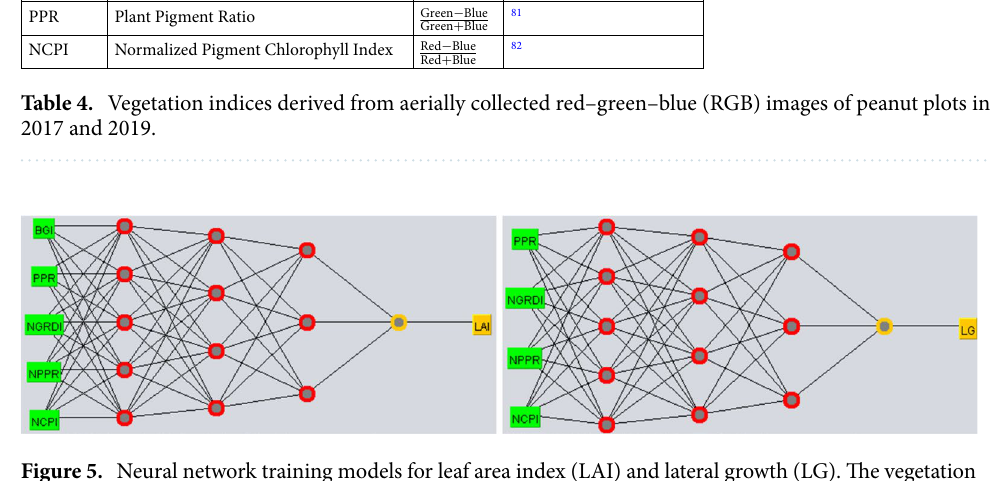
Figure 5. Neural network training models for leaf area index (LAI) and lateral growth (LG). The vegetation indices (VIs) are in green boxes as predictors and LAI and LG are in yellow boxes as predicted output. Each column of red dots represents each of the hidden layers, and each dot is a node of that layer. The neural network training was done in WEKA (Waikato Environment for Knowledge Analysis, version—3.8.4, The University of Waikato, Hamilton, New